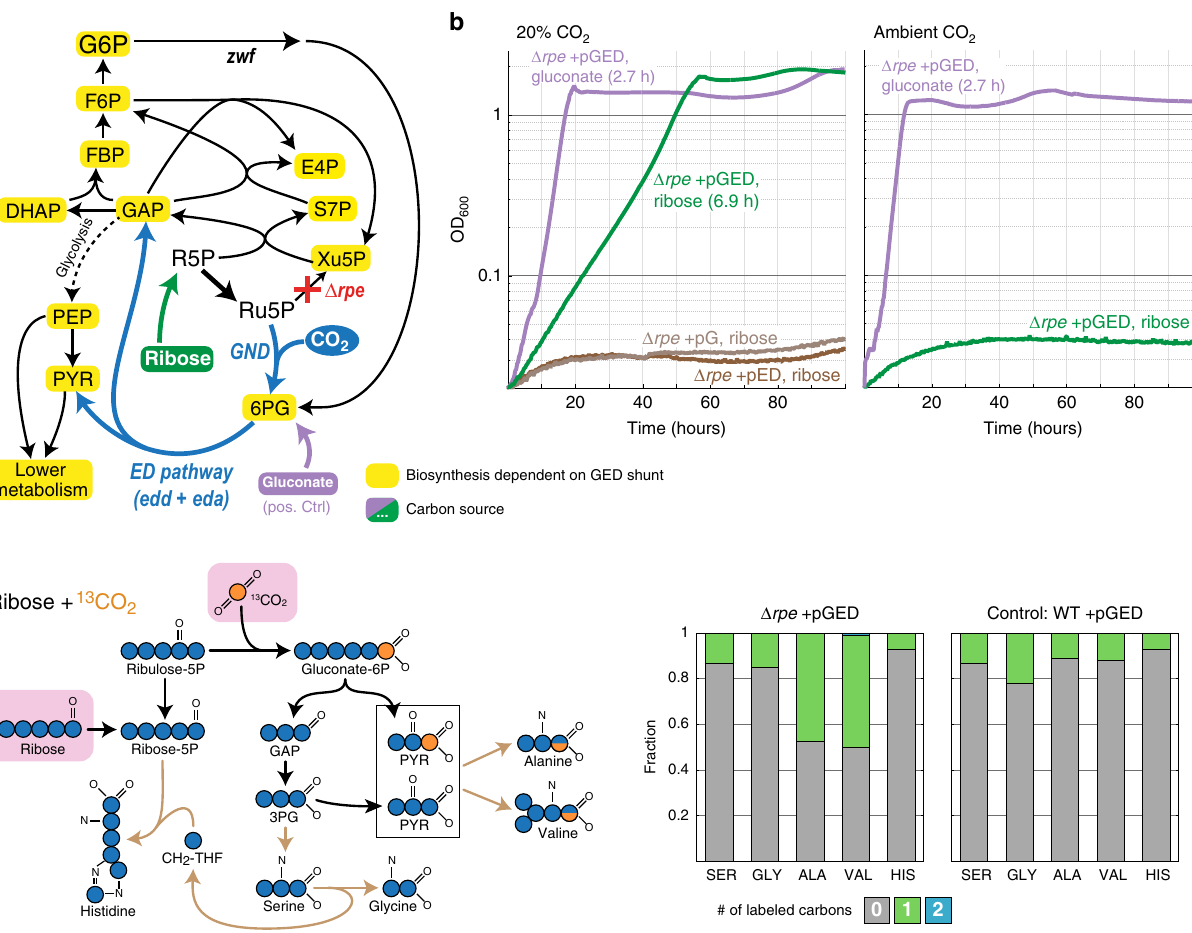
Fig. 2 Activity of the GED shunt in a Δ rpe strain. a Design of the Δ rpe selection scheme. Ribose can be assimilated only via the activity of the GED shunt, where the biosynthesis of almost all biomass building blocks is dependent on the pathway (marked in yellow). Growth on gluconate (violet) is not dependent on reductive carboxylation via Gnd and thus serves as a positive control. Reaction directionalities are shown as predicted by fl ux balance analysis. b Growth of a Δ rpe strain on ribose (20 mM) as a sole carbon source is dependent on elevated CO 2 concentration (20%, i.e., 200 mbar) and overexpression of gnd , edd , and eda (pGED). Overexpression of only gnd (pG) or only edd and eda (pED) failed to establish growth (less than two doublings). Cultivation at ambient CO 2 also failed to achieve growth. Values in parentheses indicate doubling times. Curves represent the average of technical duplicates, which differ from each other by <5%. Growth experiments were repeated independently three times to ensure reproducibility. c Cultivation on 13 CO 2 con fi rms the operation of the GED shunt. On the left, a prediction of the labeling pattern of key amino acids is shown. The observed labeling fi ts the prediction and differs from the WT control cultivated under the same conditions. Labeling of amino acids in the WT strain stems from the natural occurrence of 13 C as well as from reactions that exchange cellular carbon with CO 2 , e.g., the glycine cleavage system and anaplerotic/cataplerotic cycling. Values represent averages of two independent cultures that differ from each other by <10%. 3PG 3-phosphoglycerate, ALA Alanine, GAP glyceraldehyde-3-phosphate, GLY Glycine, HIS Histidine, PYR pyruvate, SER Serine, VAL Valine. Source data underlying b and c are provided as a Source Data fi